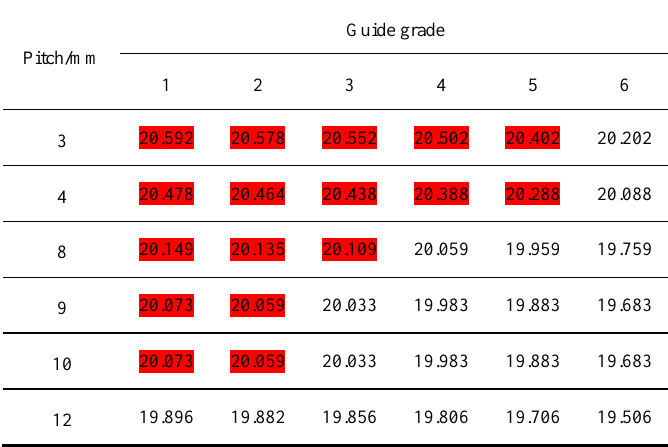
Table 7. available height of the rail when the grade is 7 (mm)